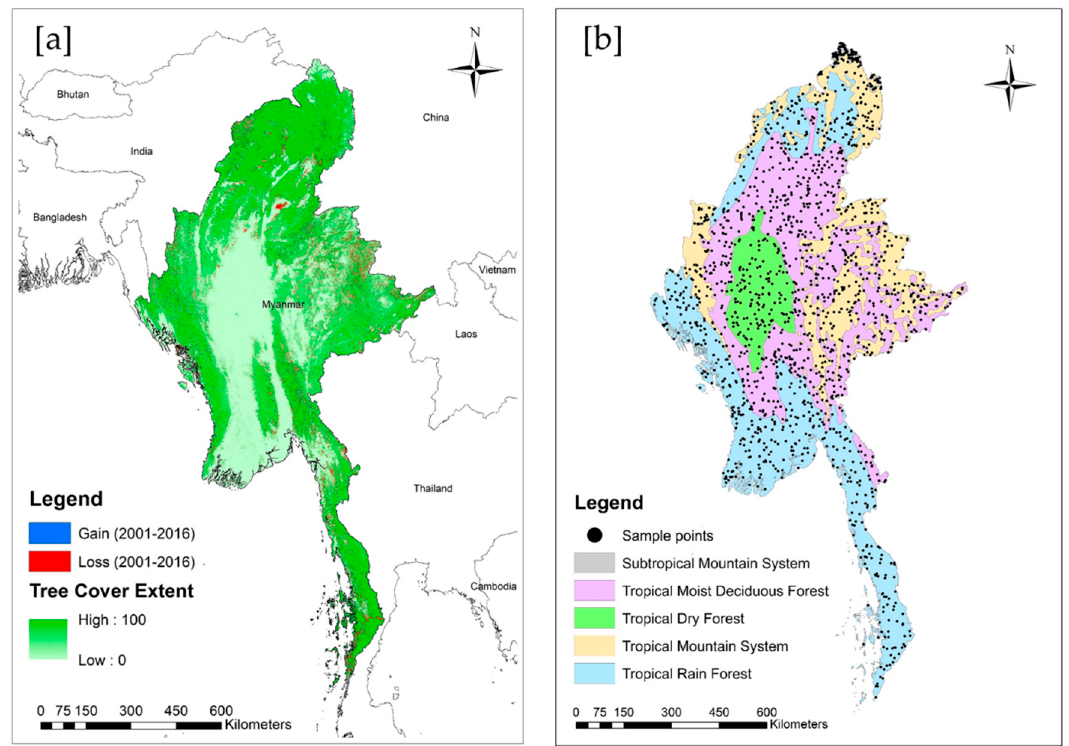
Figure 1. ( a ) Forest Cover Change from 2001–2016, ( b ) Five ecological zones showing sample points in Myanmar. The country border data were downloaded from the Database of Global Administrative Areas (GADM) [30], Forest Cover Change Data were from the Global Forest Change website [31] and the ecological zones were from the Food and Agricultural Organization website [32].